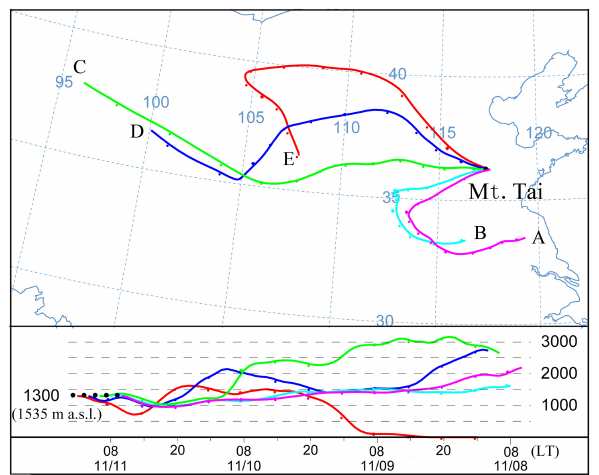
Figure 8. Air mass backward trajectories for 72h at 1535ma.s.l. at 06:00 (A), 08:00 (B), 10:00 (C), 12:00 (D), and 14:00LT (E) on 11 November